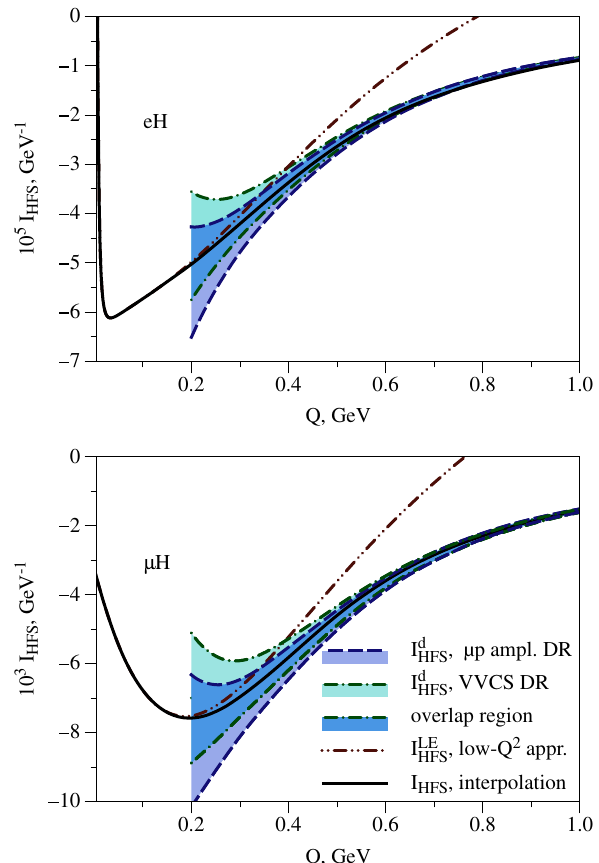
Fig. 3 Q-dependence of the integrand I HFS ( Q ) entering the TPE cor- rection to HFS. A comparison is given for the integrands based on the DRs for the lp amplitudes and based on the forward double vir- tual Compton scattering (VVCS) amplitudes. Upper panel electronic hydrogen, lower panel muonic hydrogen